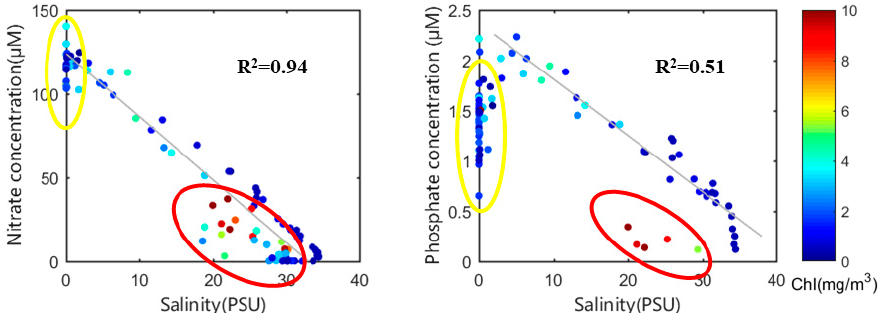
Figure 4. Relationships between in situ salinity and the concentration of nutrients. The color of the points represents chlorophyll concentration. Points circled in red indicate sites where nitrate and phosphate concentrations were significantly lower than conservative lines in high-salinity waters. Points circled in yellow indicate phosphate concentrations in the estuarine freshwater that are significantly lower than the conservative line.